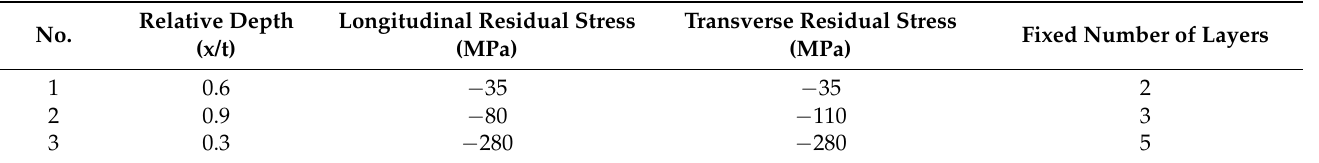
Table 9. Case study–2 using GA: Desired longitudinal and transverse residual stresses at different depths for obtaining optimised inputs with fixed number of layers.